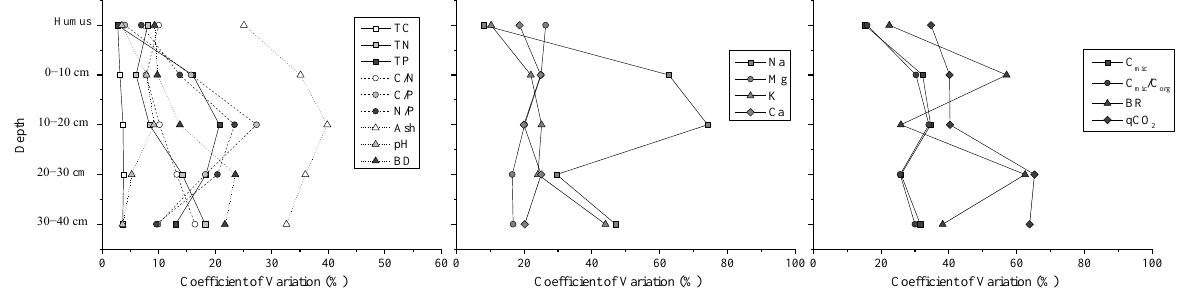
Figure 2. Coefficients of variation (CVs) (%) with depth for sample properties and microbial respi- ration activities. The CVs reflect variation at small scale for all plots, with higher CVs indicative of greater plot-to-plot variability (TC: total carbon concentration, TN: total nitrogen concentration, TP: total phosphors concentration, C/N: carbon to nitrogen ratio, C/P: carbon to phosphors ration, Ash: